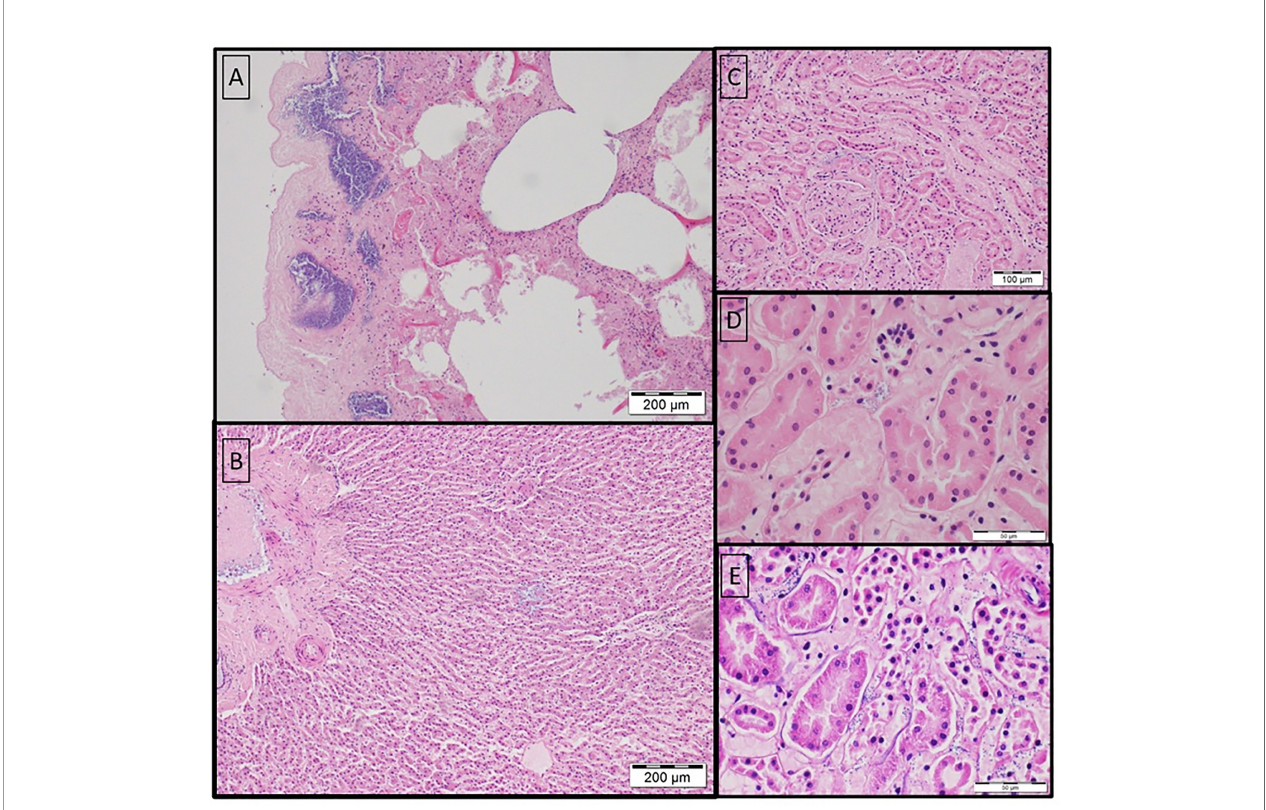
FIGURE 2 | Streptococcus agalactiae in lungs, liver, and kidney of a common dolphin. (A) Colonies of spherical or ovoid cocci, 1-2 m m in diameter, detected in subpleural alveoli and lung blood vessels (H&E stain). (B) Colonies identi fi ed inside hepatic blood vessels. No lesions or pathology was observed in the parenchyma (H&E stain). (C) Colonies and detached bacteria detected in the capillaries of the kidneys (H&E stain). Higher magni fi cation of the kidney (D) and Gram-positive cocci con fi rmation in kidney samples (E) ; (Gram